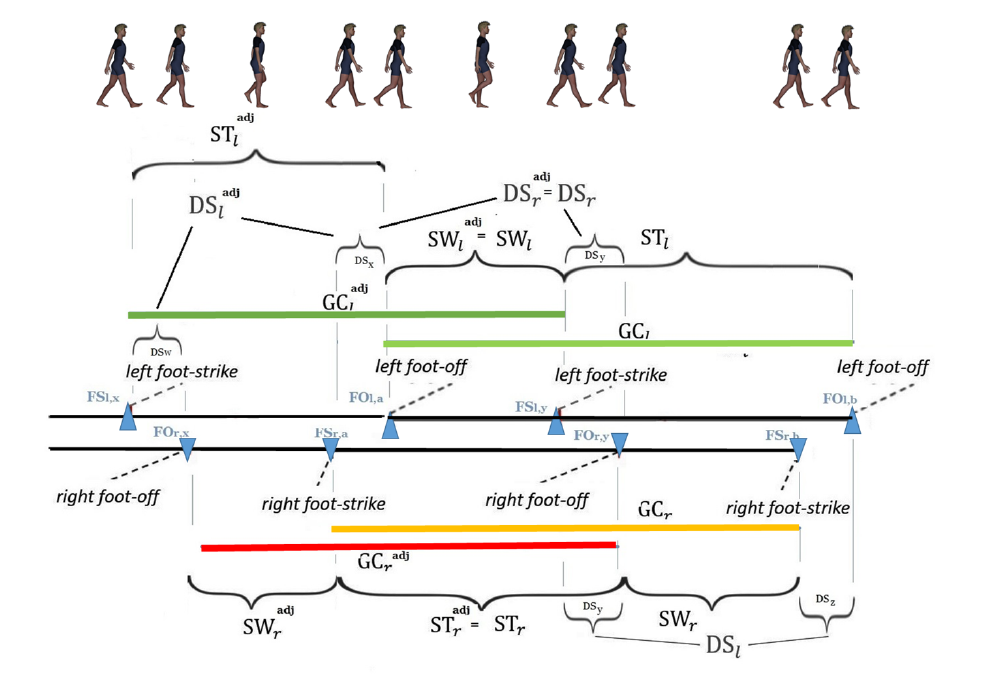
Figure 1. Composite gait cycle : right and left gait cycles and adjoint right and left gait cycles. Let the right (respectively, left) stance have time duration ST r (respectively, ST l ). The durations of the right swing and left swing phases [19] are given